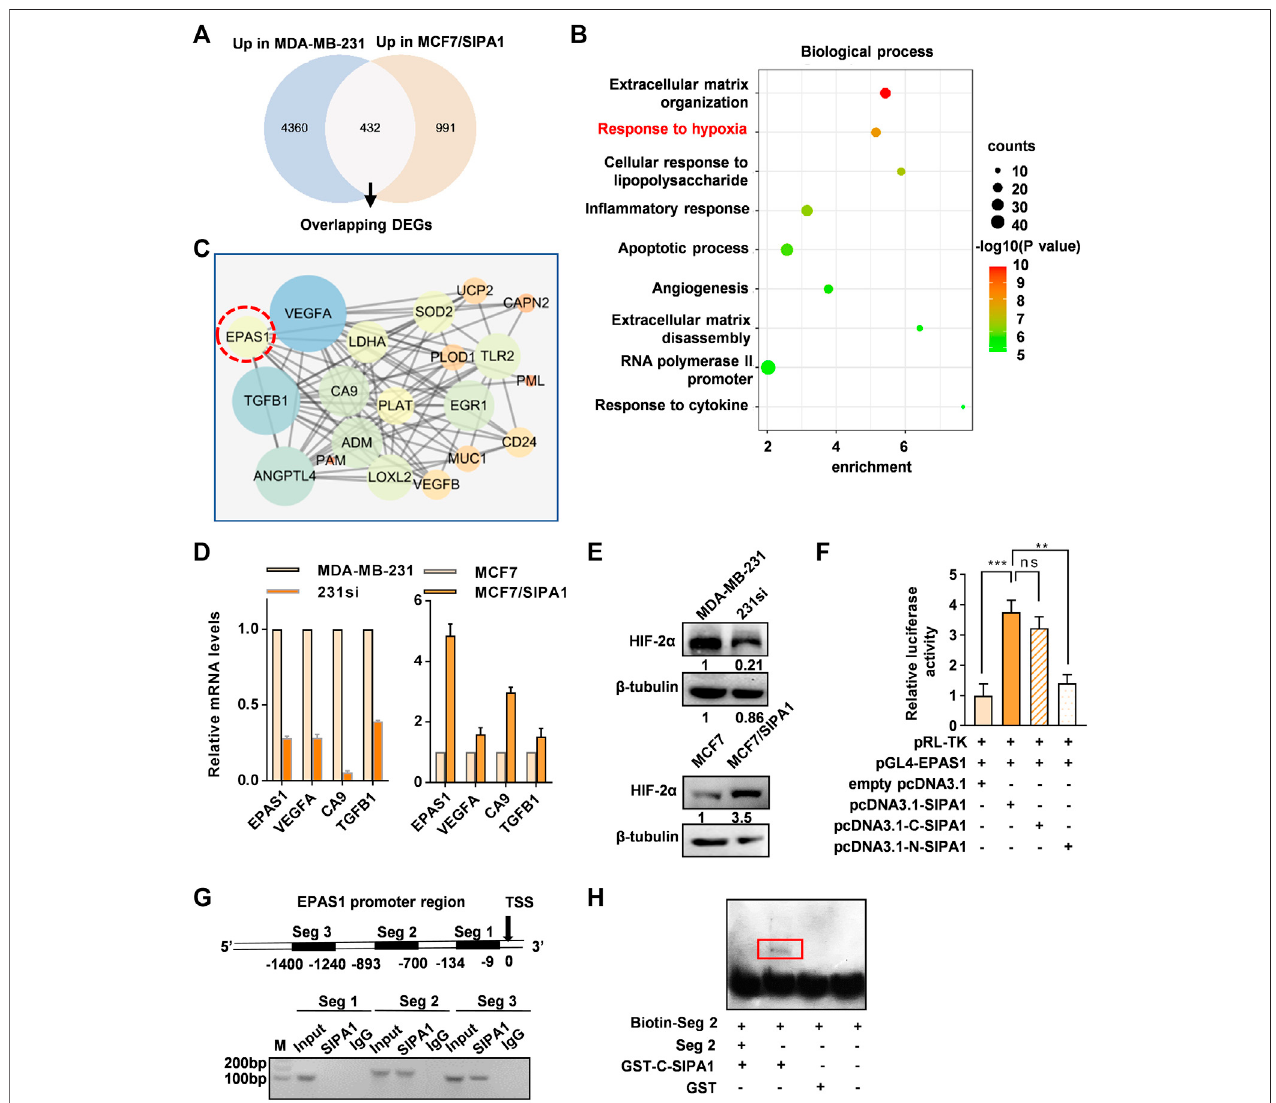
FIGURE 3 | SIPA1 upregulates EPAS1 transcription by binding to its promoter region. (A) Transcriptome sequencing datasets of two pairs of cells (MDA-MB-231 vs 231si, MCF7 vs MCF7/SIPA1) were analyzed and 432overlappingcandidategeneswhich were positively regulated bySIPA1 wereselected inthe Venn diagram. (B) GO biological process enrichment analyses of the 432 genes positively correlated with SIPA1. Top nine GO terms were listed with p values, counts and enrichment scores. (C) Genes allocated to “ responses to hypoxia ” in (B) were plotted as a protein-protein interaction network. (D) qRT-PCR analyses of EPAS1 and its downstream gene candidates, TGFB1 , VEGFA and CA9 . Data were shown as mean ± s.d. The experiments were conducted in triplicate. SDHC was included as an endogenouscontrol. (E) WesternblottinganalysesofHIF-2 α expressioninbreastcancercellswithvariousSIPA1levels. β -tubulinwasincludedasaninternalcontrol. (F) The effect of SIPA1 on EPAS1 promoter activity were accessed by a luciferase reporter assay. (G) Interaction of SIPA1 with EPAS1 gene promoter revealed by ChIP- PCR. Seg 1, Seg 2 and Seg 3 represented the indicated promoter regions. TSS, transcription start site. (H) Interactions of truncated SIPA1 protein (540-1042aa) with EPAS1 gene promoter segment 2 were revealed by EMSA. Data shown are mean ± s.d. of triplicate measurements (n (cid:1) 3).